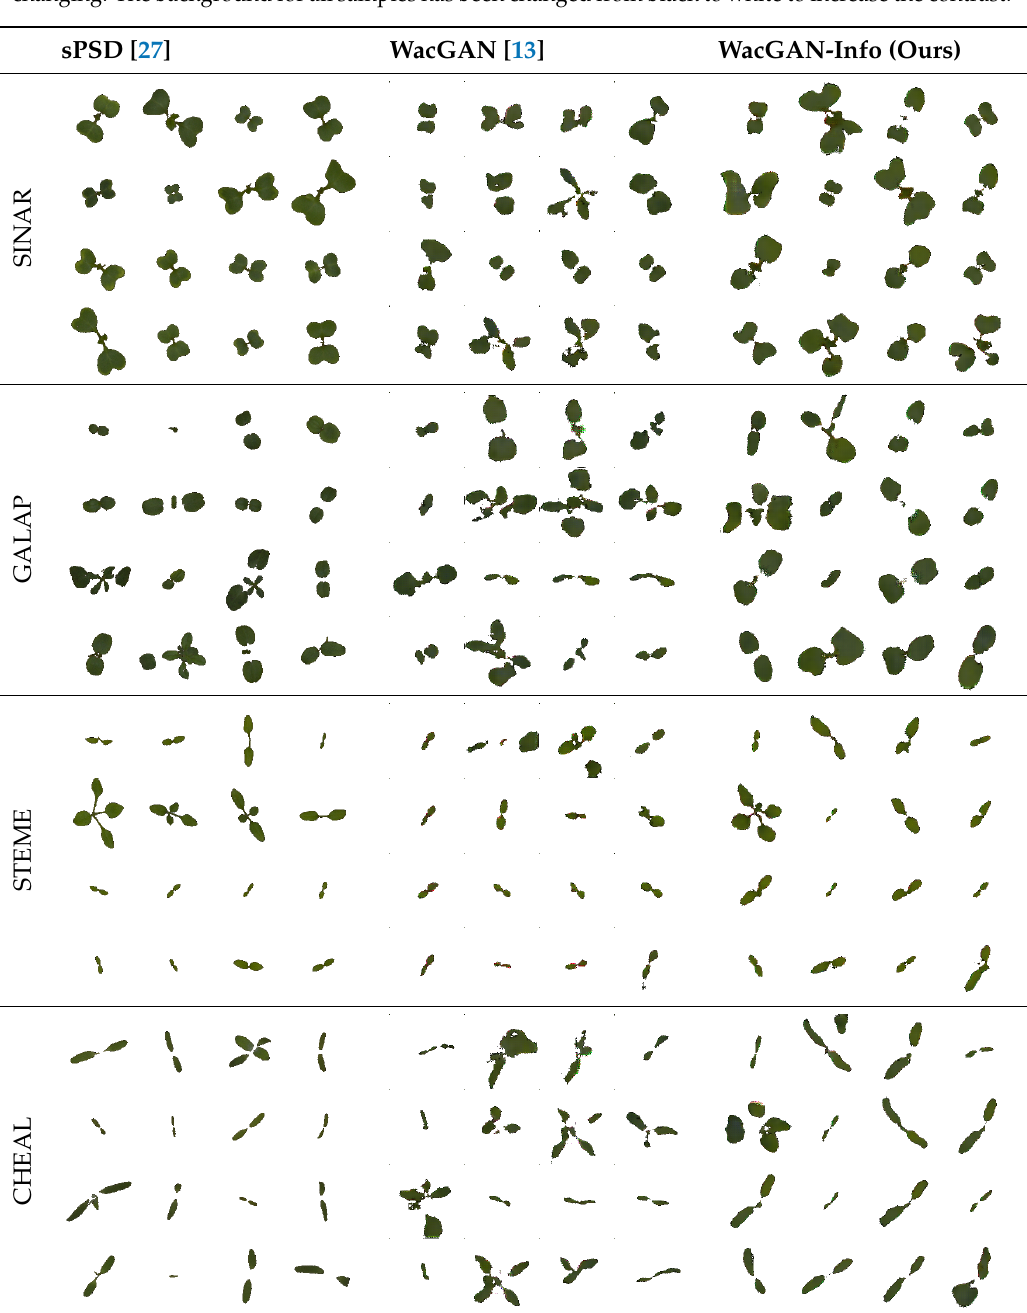
Table 2. Examples of plant seedlings from sPSD [27], WacGAN [13], and WacGAN-info. The 16 samples for each species were generated using the same fixed random noise vectors, with only the class encoding changing. The background for all samples has been changed from black to white to increase the